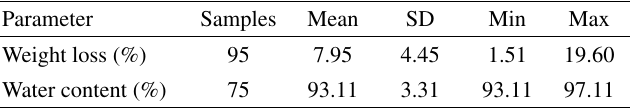
Table 1 - Statistical analyses of sample sets relative to the two analyzed parameters (weight loss and water content) during the first experiment Parameter Samples